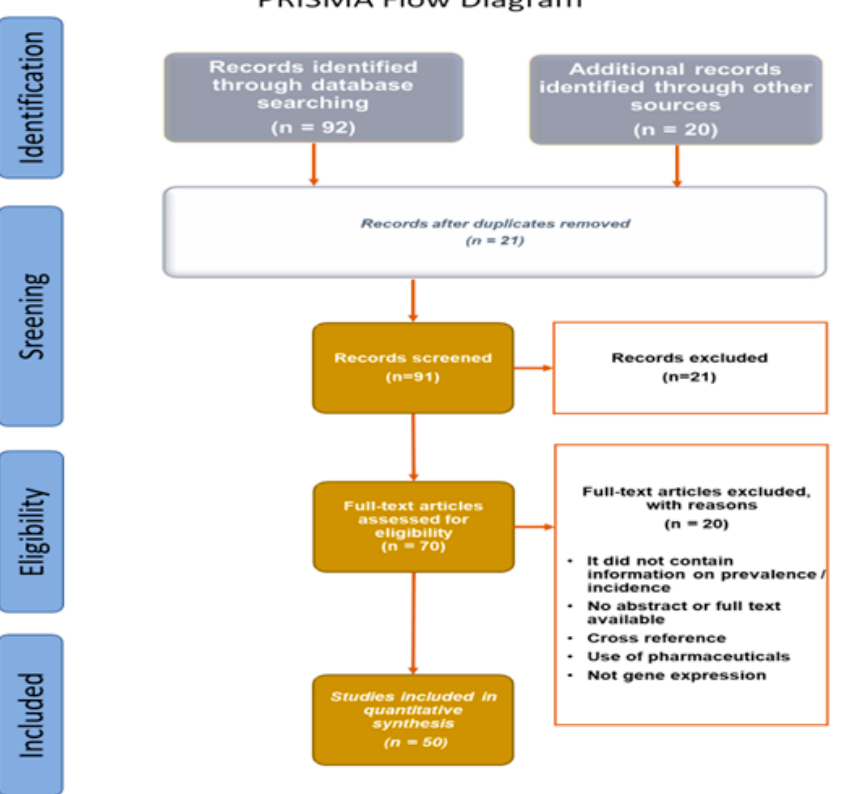
Figure 4. PRISMA flow diagram of data extracted from bibliographic Figure 4. PRISMA fl ow diagram of data extracted from bibliographic searches.